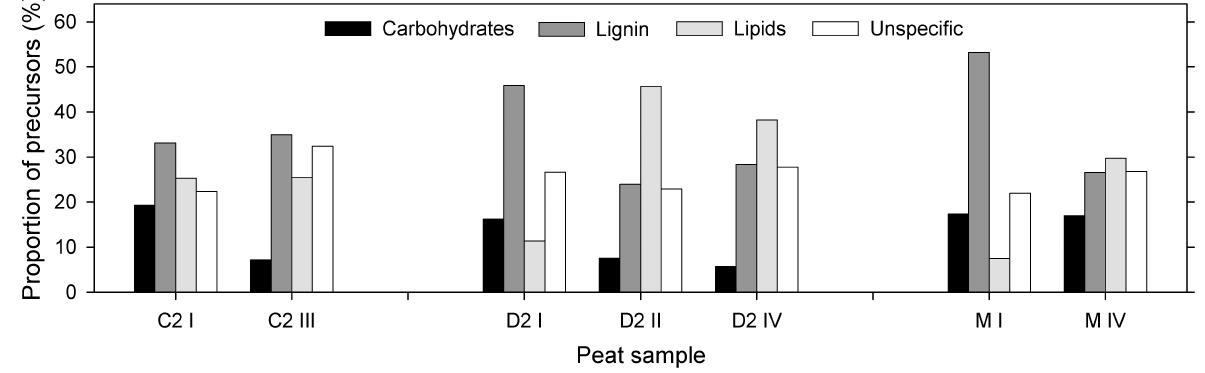
Fig. 4. Relative proportion (% of total pyrolyzable compounds) of identified compounds grouped by precursor classes of chemical compounds (carbohydrates, lignin, lipids and unspecific C-based compounds) from different peat samples obtained from an acidic fen (C2: middle part, D2: more southern part, M: most southern part) over 4 depths (I: 0–10cm, II: 10–20cm, III: 20–30cm and IV: 30–40cm). Compounds were identified using Curie-point pyrolysis-gas chromatography/mass spectrometry ( n